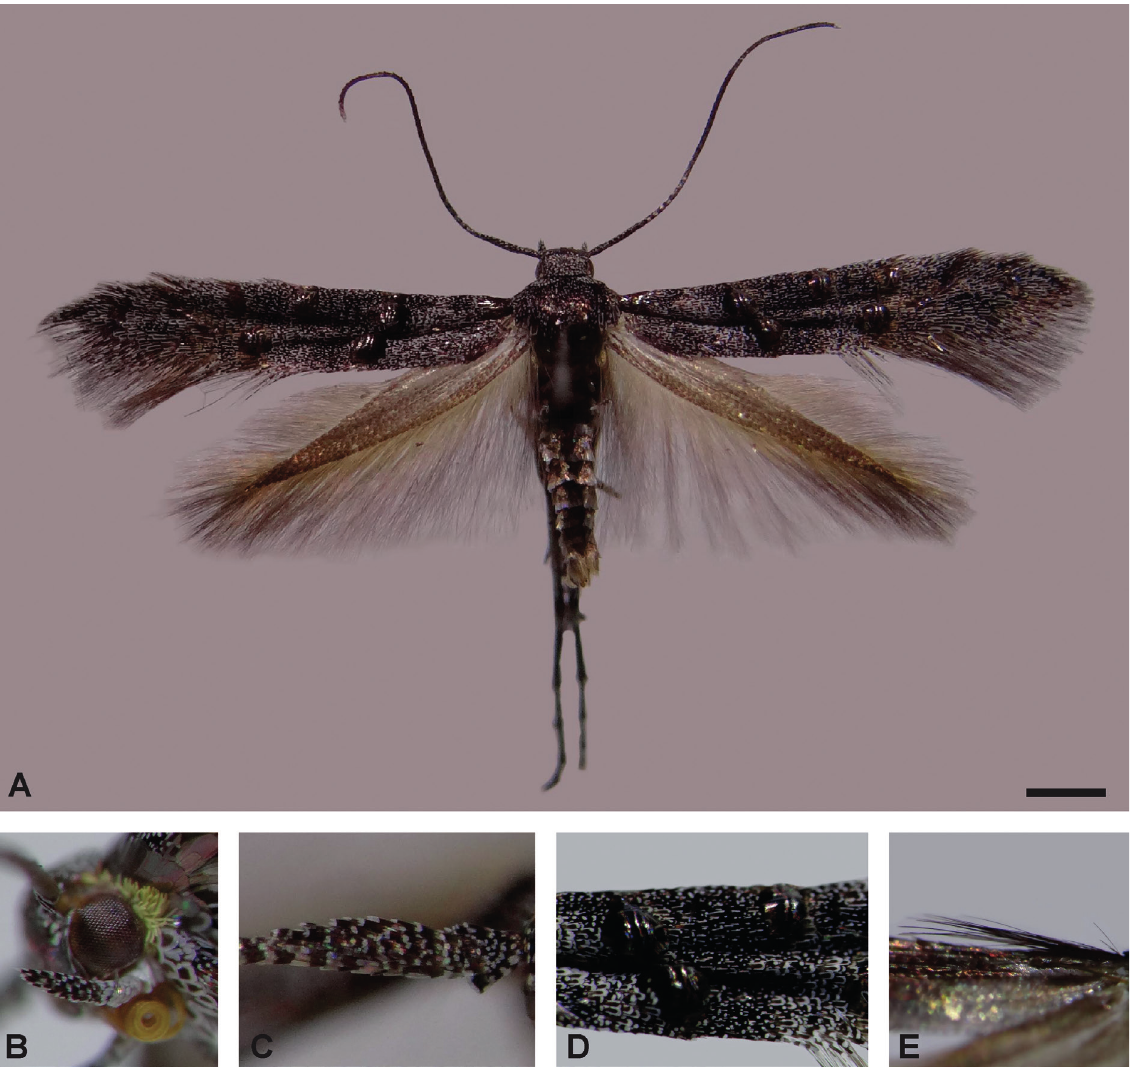
Fig. 3. Helioandesia tarregai gen. et sp. nov., ♂, holotype (IDEA-LEPI-2020-015). A . Dorsal view. B . Head, lateral. C . Basal flagellomeres of right antenna. D . Three bulging metallic spots on the basal half of forewing. E . Hair pencil from base of subcosta, ventral. Scale bar: 1